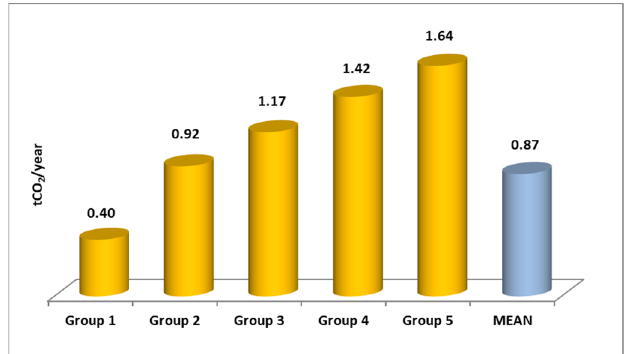
Figure 15. Mean CO 2 emissions per household by group of cities without the influence of climate.